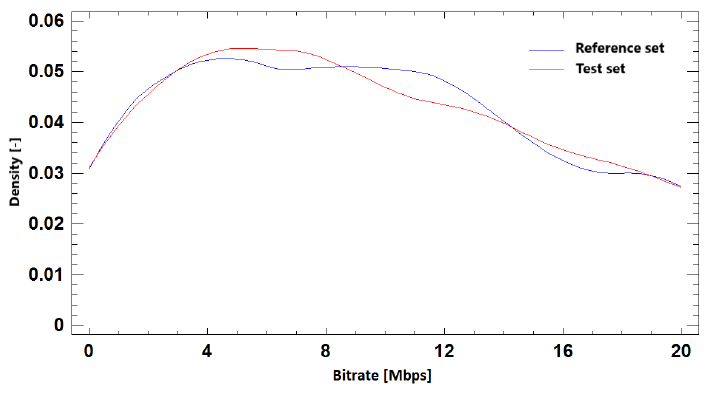
Figure 27. The probability density function for bitrate prediction based on MOS, Ultra HD, H.264 + H.265.